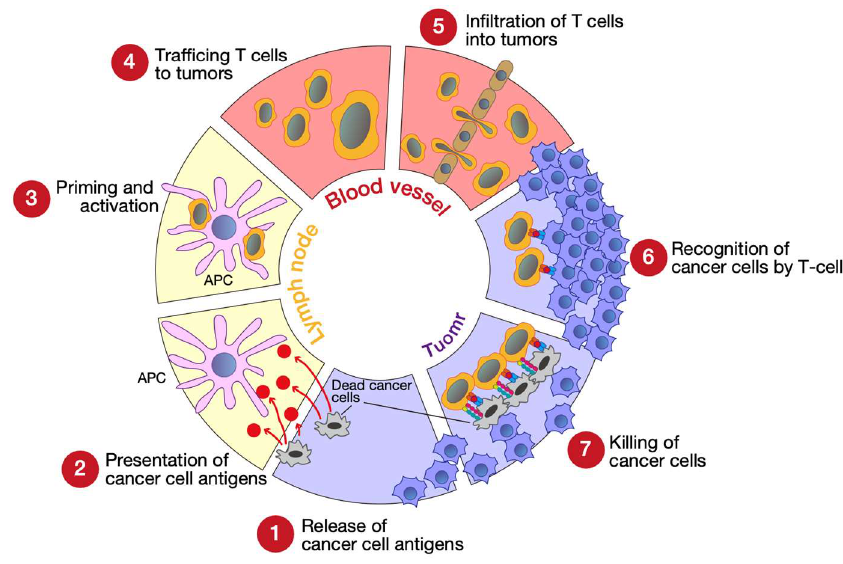
Figure 1. Seven steps of the cancer-immunity cycle. APC, antigen-presenting cell (e.g., dendritic cell). This figure was illustrated using Adobe Illustrator 2022 (Adobe, San Jose, CA USA) based on ref [3].